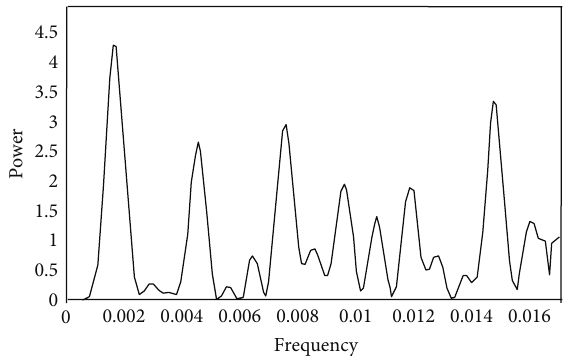
Figure 7: Spectral analysis of the magnetic susceptibility at 700 ∘ C along the core from sebkha Mhabeul.